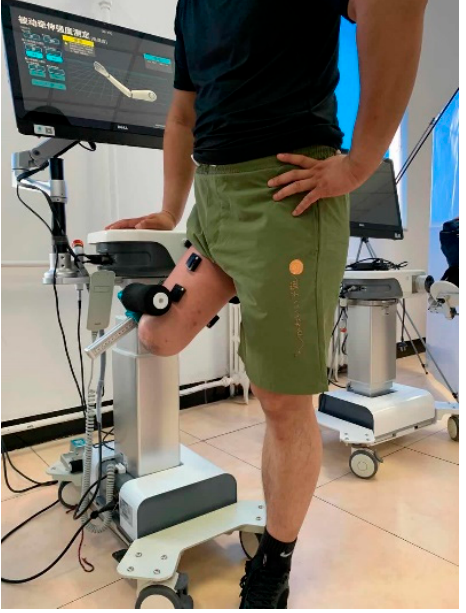
Figure 4. Simulated exercise experiment of the residual limb by the rehabilitation robot.